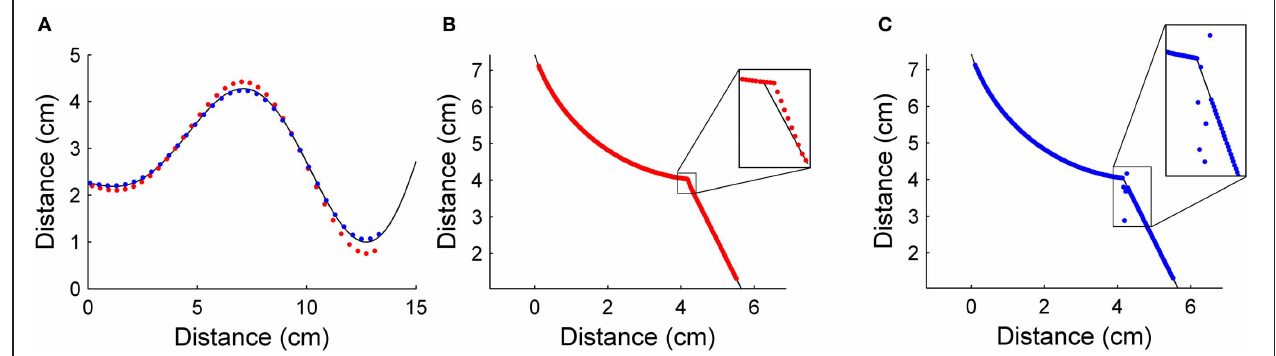
FIGURE 6 | (A) Radial distance predictions using both local object slope (red dots) and curvature (blue dots) for a shape with gradually changing curvature. Prediction error is 6 . 37 ± 6 . 81% for local slope prediction and 3 . 02 ± 1 . 52% for local curvature prediction. It can be seen that local slope prediction leads to a slight overshoot when object curvature increases.